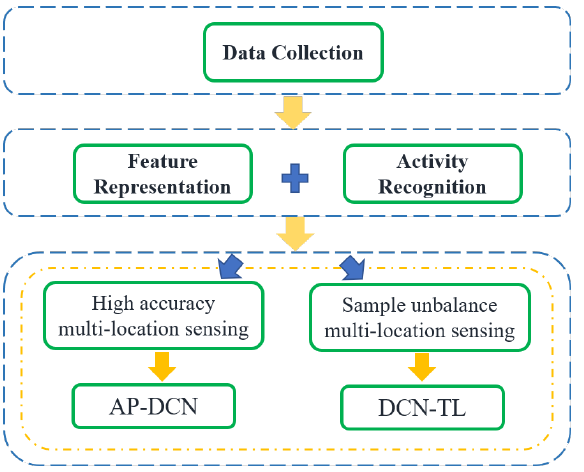
Figure 4. The framework of multi-location human activity recognition